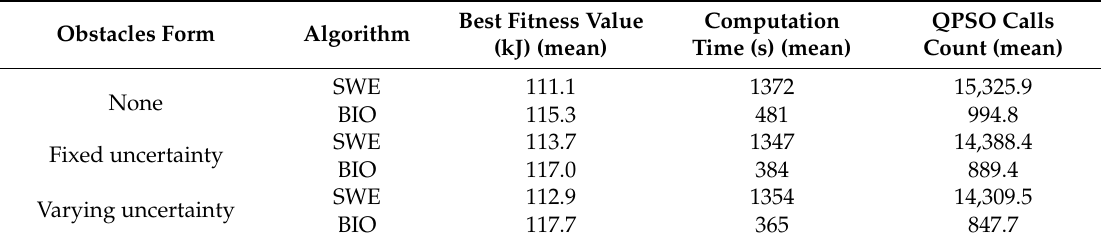
Table 3. Performance comparison of BIO and SWE based on 100